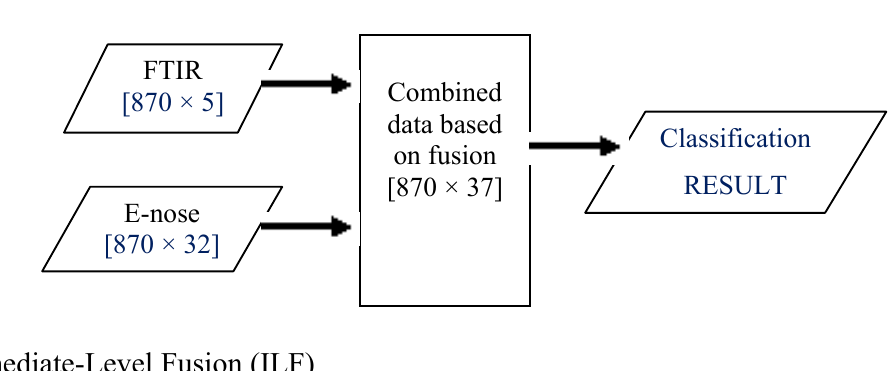
Figure 4. Low-level fusion scheme.